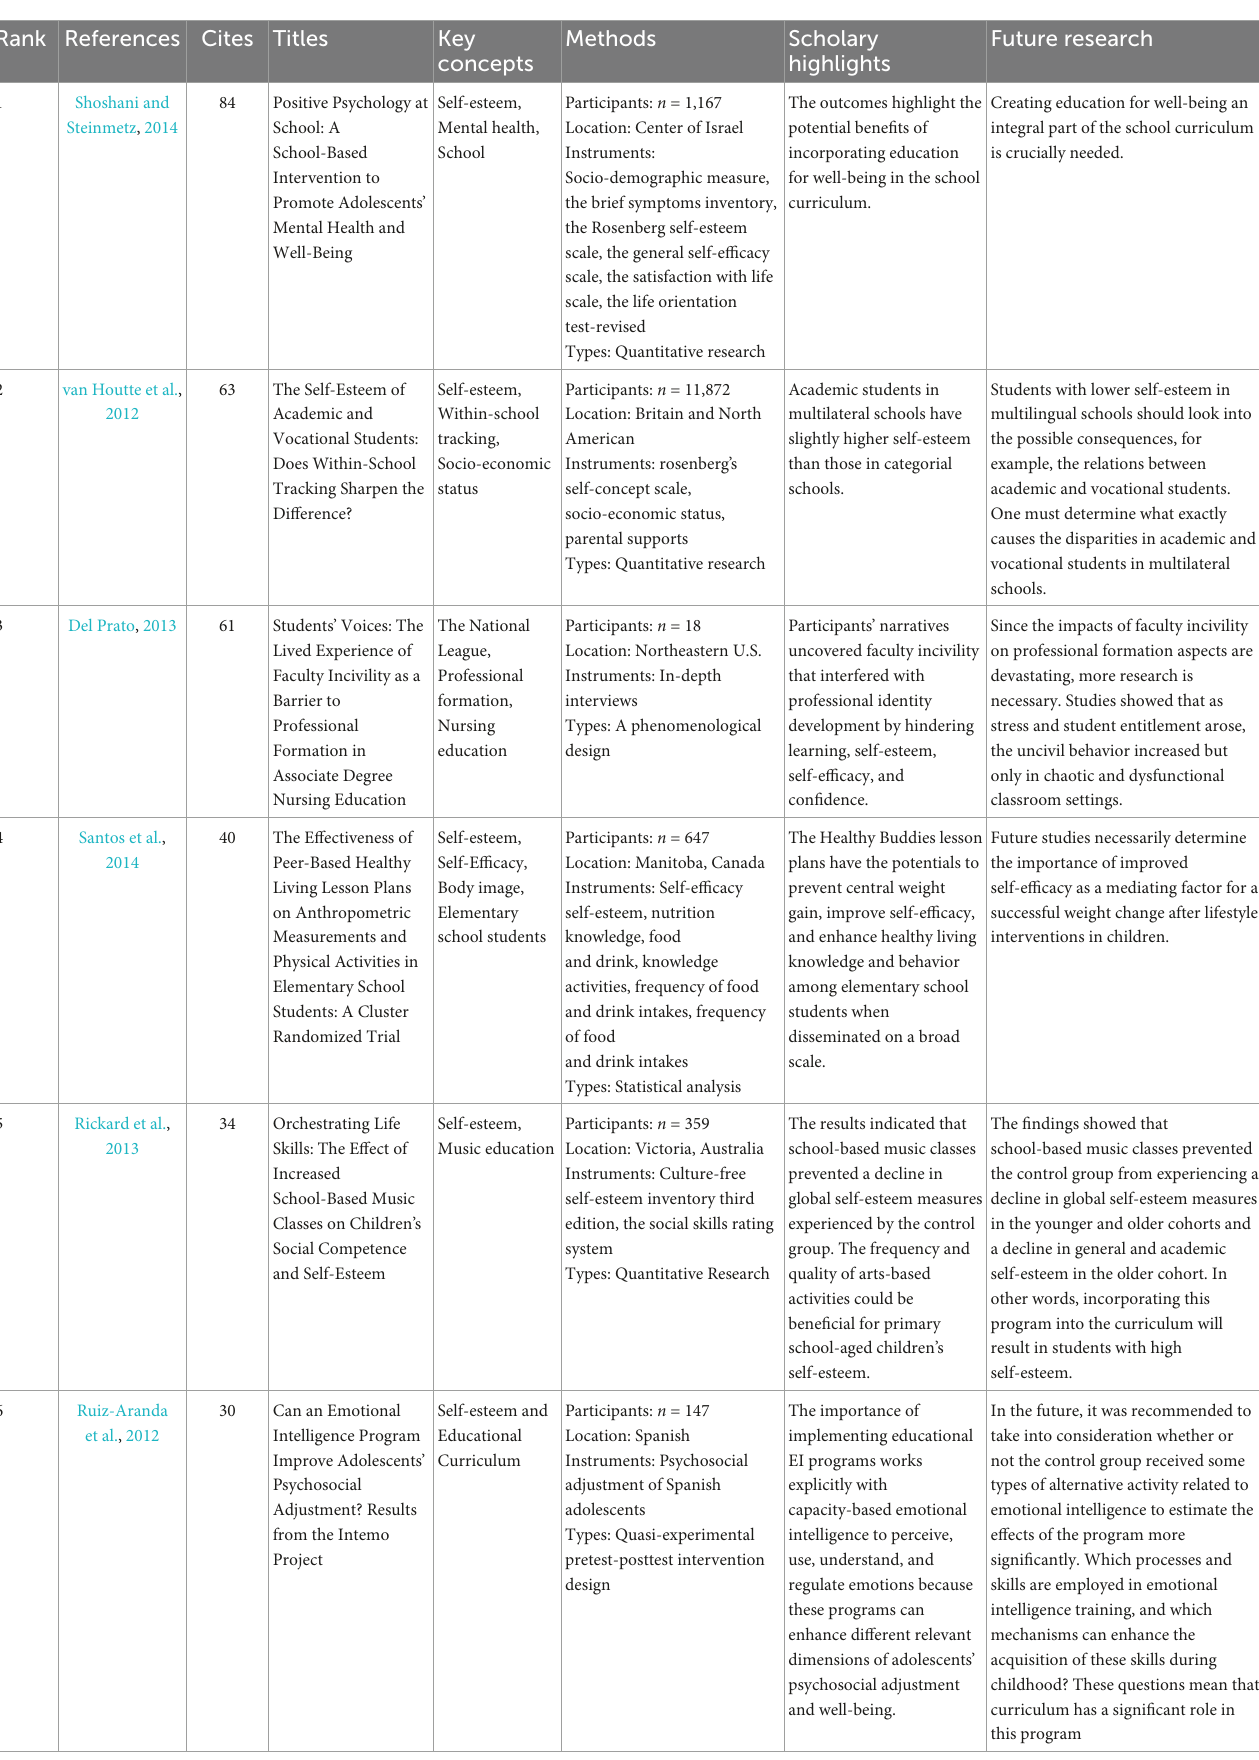
TABLE 2 Ten best articles on curriculum development and self-esteem in